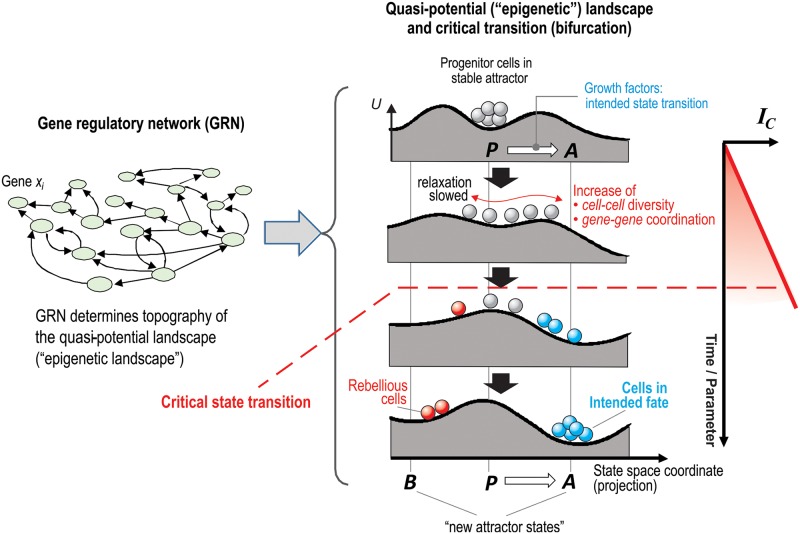
Epigenetic landscape model of symmetry-breaking bifurcation event.The architecture and the specification of the individual interactions of the gene regulatory network (left) determines the topography of the epigenetic landscape (center) in which the elevation (formally, a quasi-potential U) [29] visualizes the relative stability of individual cell states, represented by the position with respect to the x-axis (state space). Thus, valleys represent stable attractor states. Fate commitment is induced by external differentiation signals, which initiate the deformation of the landscape and can be divided into two phases: first, the destabilization of the (meta)stable attractor of the progenitor cells (grey balls) and generation of a poised unstable state; and second, the opening of access to the destination attractors for both the intended and non-intended fate, biased toward the former by the differentiation signal. This allows the cells (balls) to descend to the new attractors. The disappearance of the progenitor attractor marks the critical transition (tipping point). As explained in S2 Appendix, the increase in cell–cell variation and in gene–gene correlation as the progenitor attractor destabilizes and cells spread and align along the particular direction (reaction coordinate) to exit the old attractor gives rise to a gradual increase of the index IC (right) as cells approach the critical transition. This event coincides with lineage separation in state space and a major shift in cellular transcriptome. (Note, however, that there is no proof that IC reaches a peak just at the tipping point.)